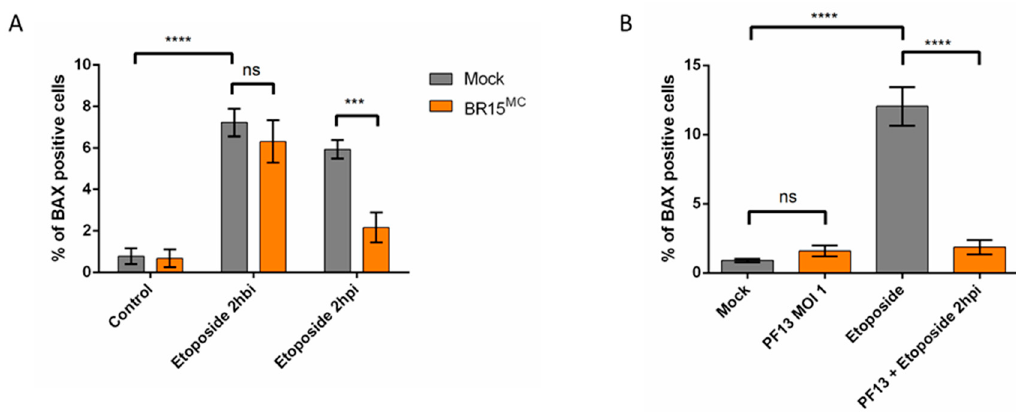
Figure 4. ZIKV provides a protection against intrinsically induced cell death by etoposide. ( A ) A549 cells were infected with BR15 MC at MOI of 1 for 8 h and treated with etoposide 2 h before infection (2 hbi) or 2 h post infection (2 hpi). The percentage of A549 cells immunostained with anti-BAX antibody was followed. ( B ) A549 cells were infected with PF13 at MOI of 1 for 8 h and treated with etoposide for 16 h, 2 hpi. The percentage of A549 cells immunostained with anti-BAX antibody was followed. Values represent the mean and standard deviation of three independent experiments Data were analyzed by a one-way ANOVA test with post-hoc Tukey’s test (*** p < 0.001, **** p < 0.0001, ns = not significant).